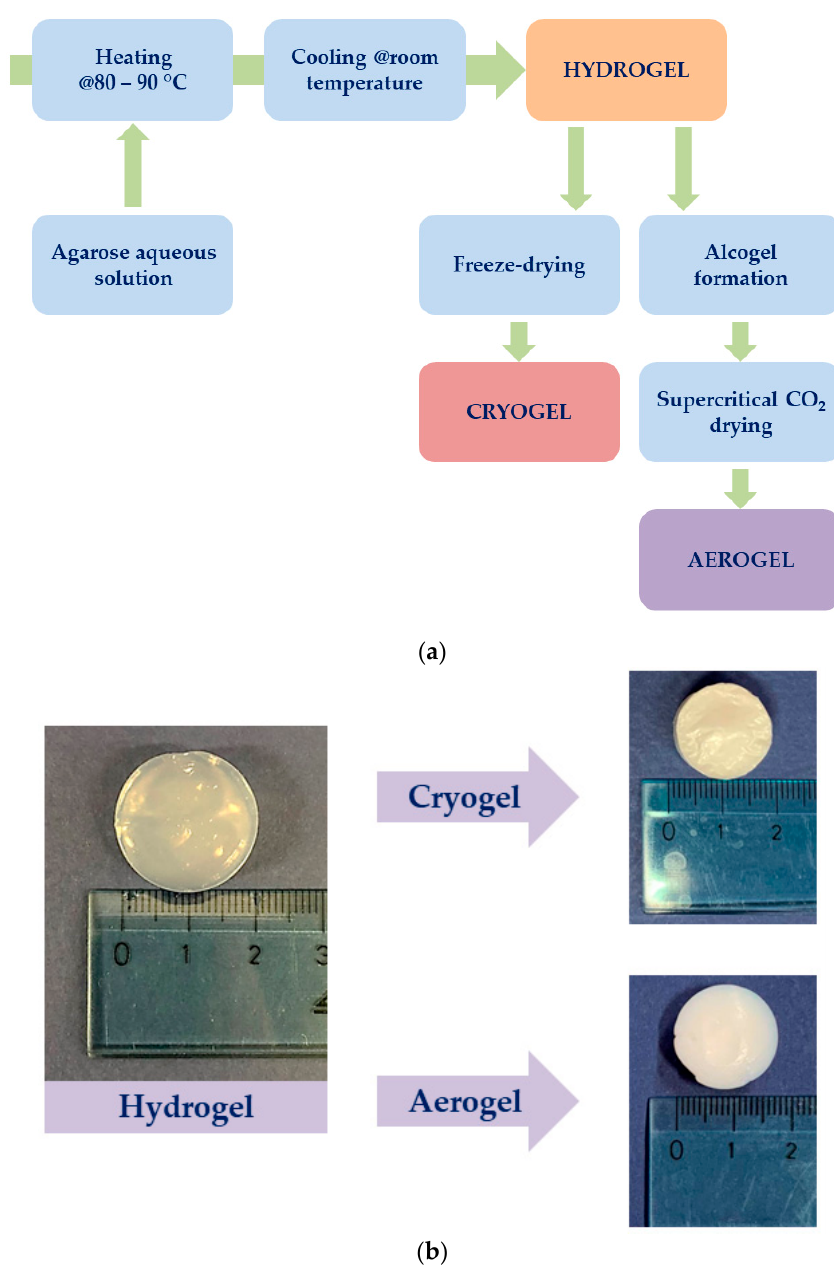
Figure 8. Schematic representation of agarose cryogels and aerogels preparation ( a ) and samples obtained ( b ).4.2.1. Hydrogel Preparation.